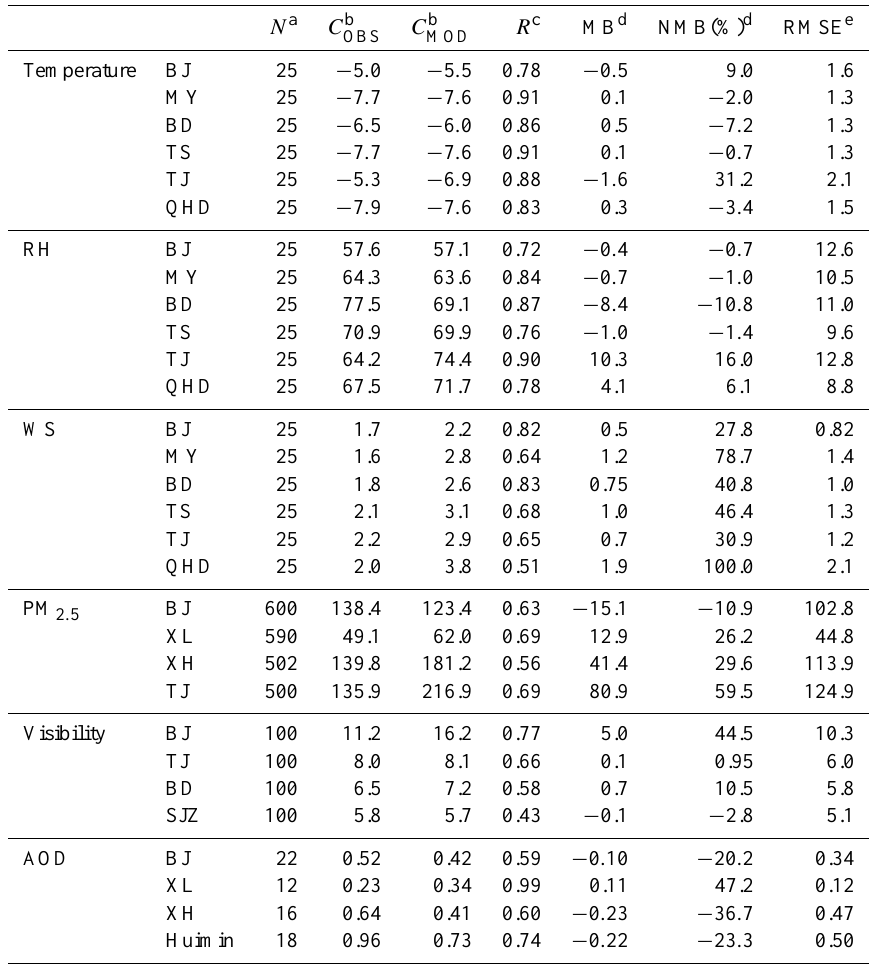
Table 1. Statistics of the comparisons between simulated and observed temperature ( ◦ C), relative humidity (RH, %), wind speed (ms − 1 ), surface PM 2 . 5 concentration (µgm − 3 ), visibility (km), and aerosol optical depth (AOD) during 2–26 January